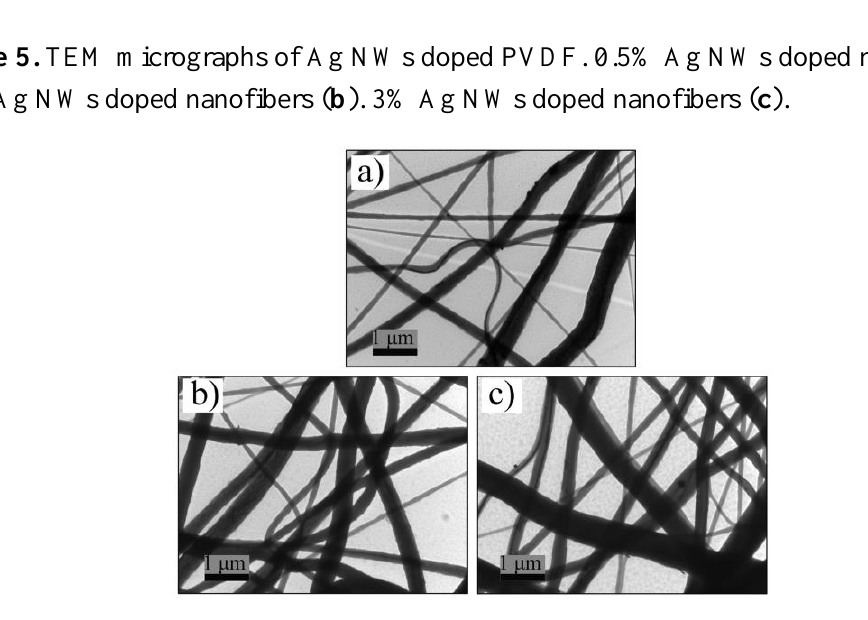
Figure 6. EM micrographs of Ag NWs ( a , b ). nanofibers of pure PVDF ( c , d ). nanofibers of 1.5 wt% Ag NWs doped PVDF ( e , f